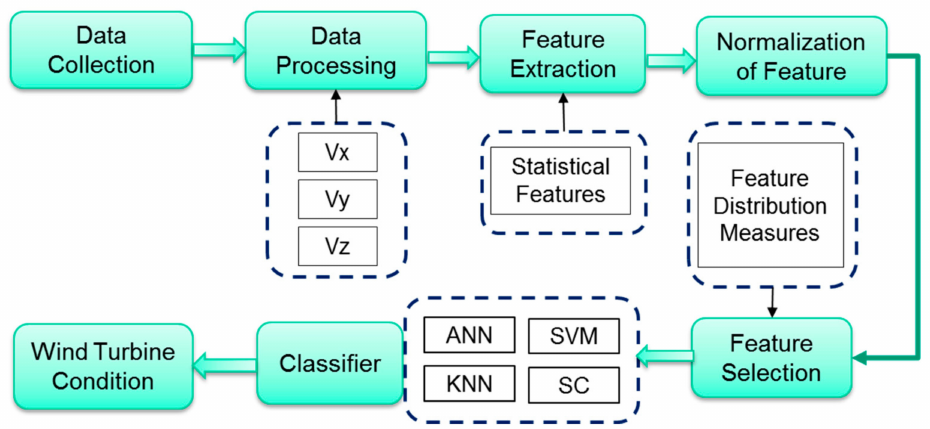
Figure 5. Scheme of wind turbine condition monitoring